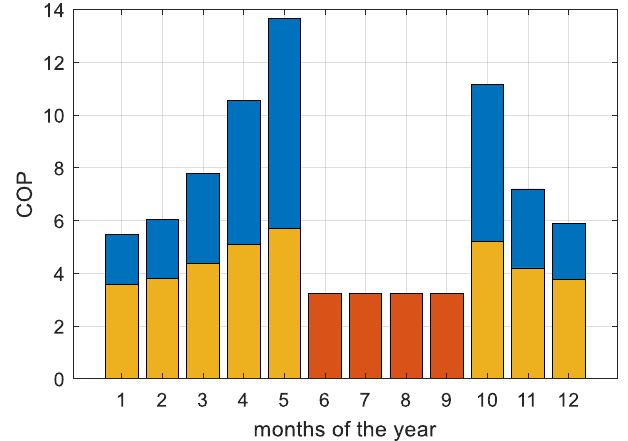
Figure 4. Coefficient of performance (COP) with (blue) and without (orange) sorption storage in heating operation and charging operation (red).